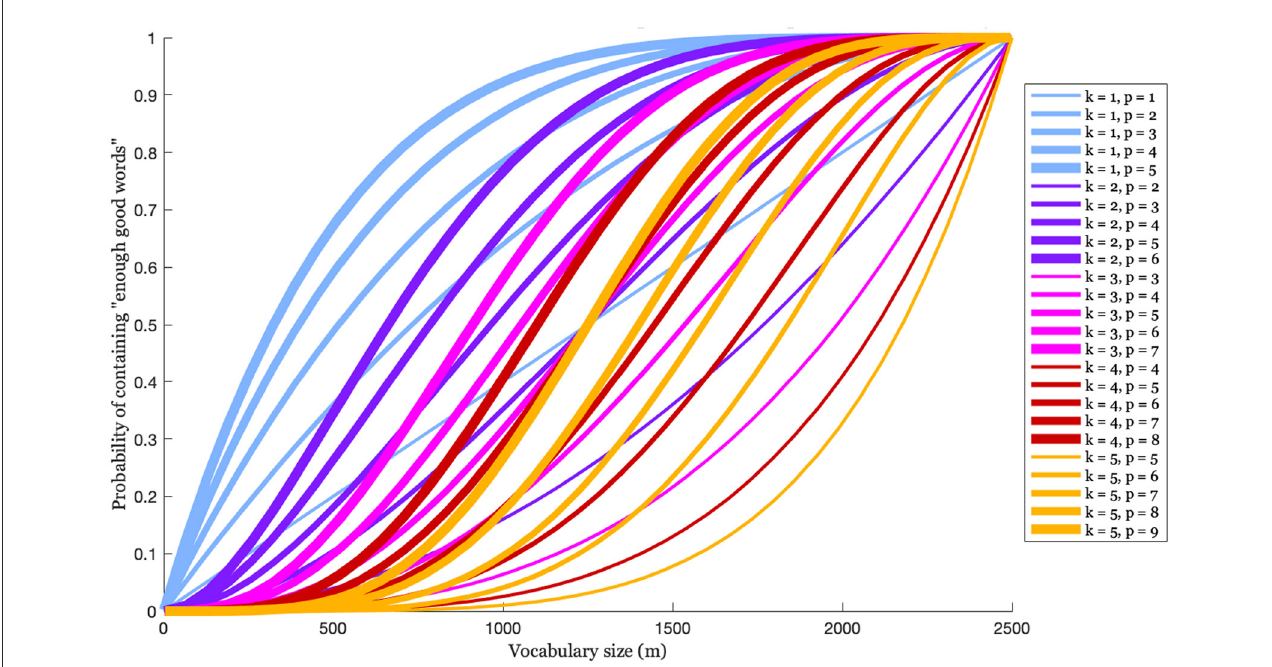
FIGURE10 The probability that an expressive vocabulary of size m , drawn randomly from a larger vocabulary size of 2,500 words, contains at least k of the p words in L that are the closest perceptual matches to an exemplar that represents some novel word.